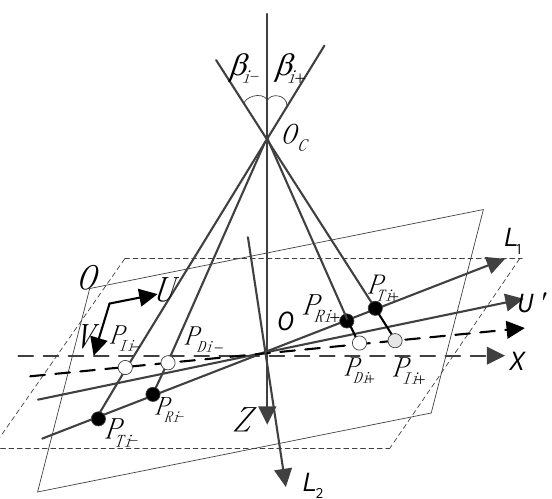
Figure 16. Calibration schematic